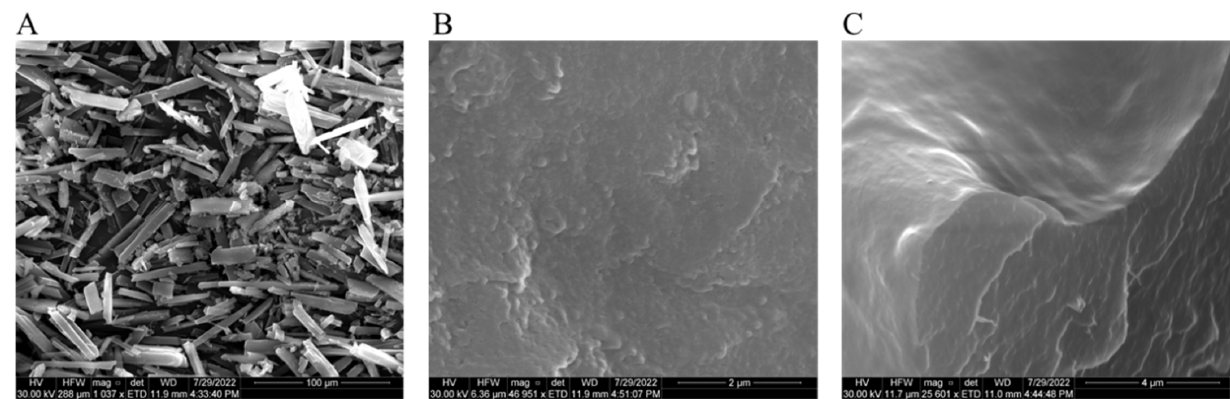
Figure 6. Scanning electron micrographs of ( A ) DFS crystals, ( B ) freeze ‐ dried DFS ‐ NS before DMN loading, and ( C ) magnified image of DFS ‐ NS embedded into the DMN tips.